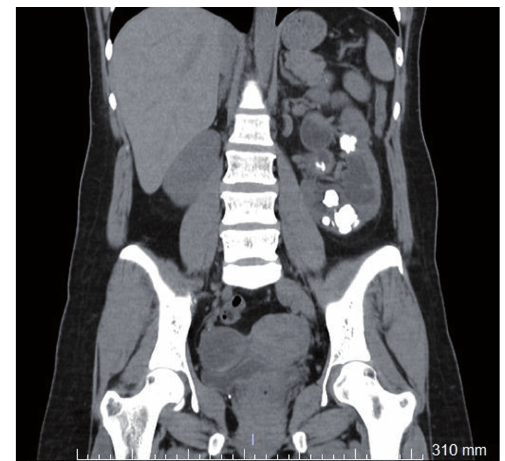
figure 1 - computed tomography scan with multiple calculus in left kidney.